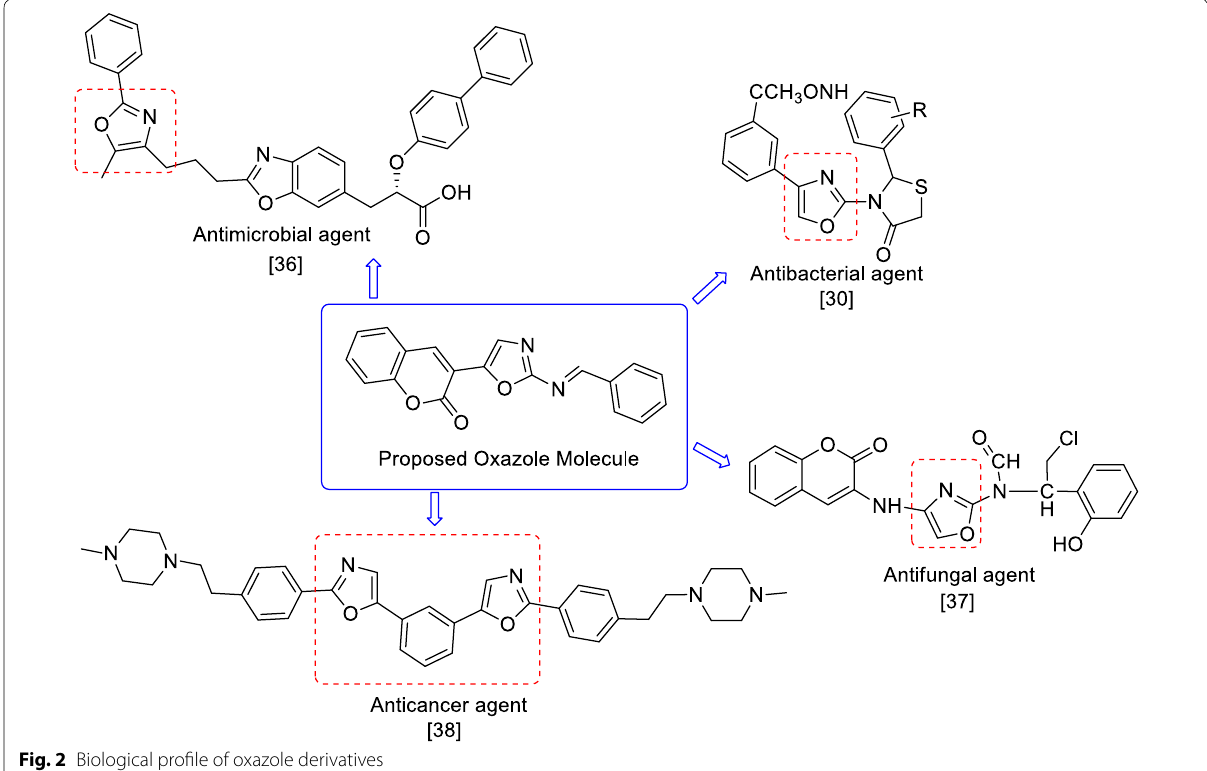
Fig. 2 Biological profile of oxazole